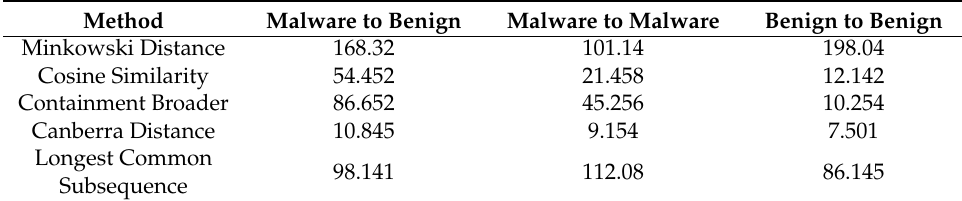
Table 3. Similarity analysis mean matrix result [j × i].